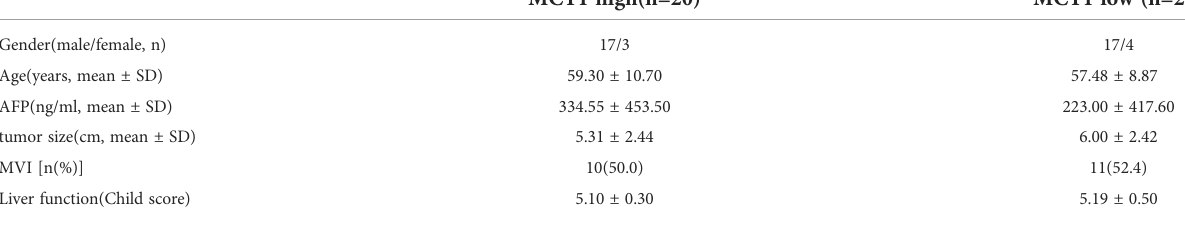
TABLE 1 Patient